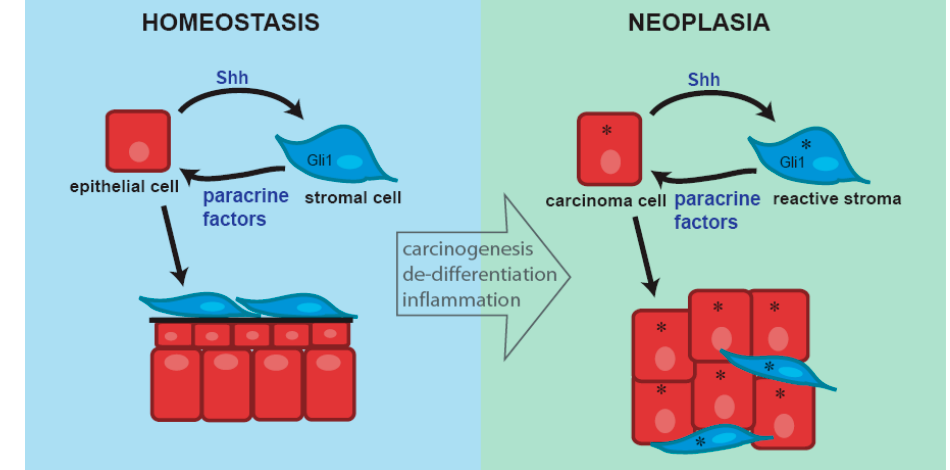
Figure 6. The target genes activated by paracrine Hh signaling in the adult prostate and the effect on epithelial/tumor cell proliferation is determined by the phenotype of the stroma. In the normal adult prostate and prostate cancers with a normal fibroblastic stroma the target gene profile resembles that of the postnatal prostate and the effect of paracrine Hh signaling is homeostatic. In prostate cancers with a so-called “reactive” (myofibrobastic) stroma, the target gene profile resembles that of the prenatal prostate and the effect of paracrine signaling is to promote epithelial/tumor cell proliferation. Autocrine signaling in tumor stem cells may enable these cells to survive castration and enable androgen independent tumor growth.